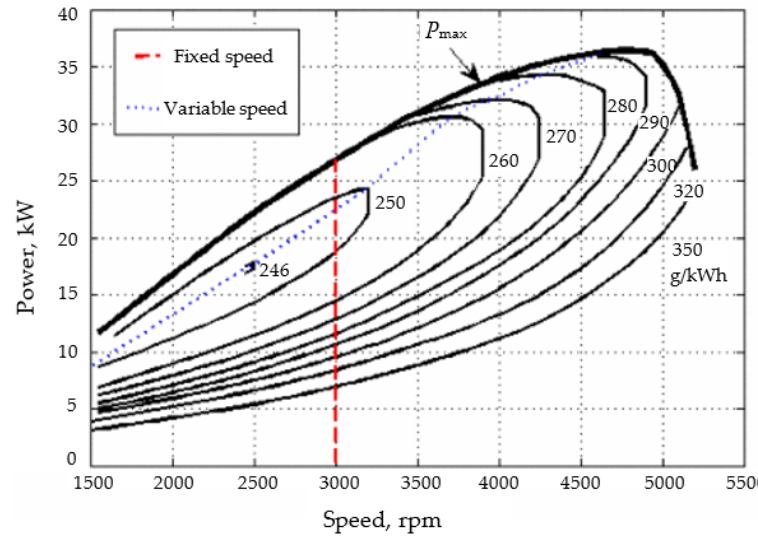
Figure 5. Fuel map of a 25 kW (3000 rpm) diesel engine. Adapted from Ref. [85].